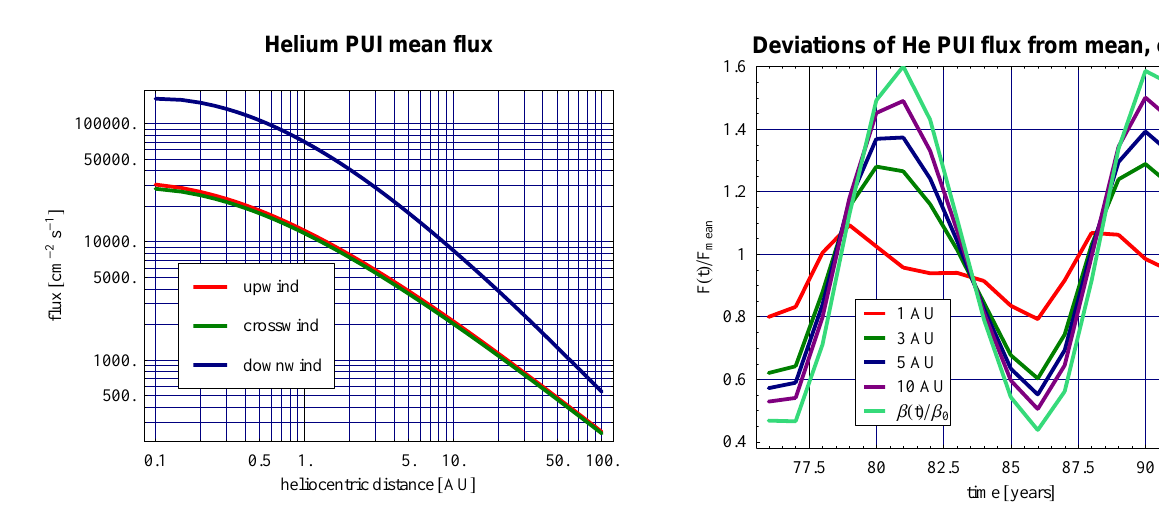
Fig. 11. Mean flux of He + pickup ions upwind, crosswind and downwind in the log-log scale for the He density at infinity equal to 1 atom cm − 3 and stationary ionization rate equal to the mean value of the function presented in Fig. 1.